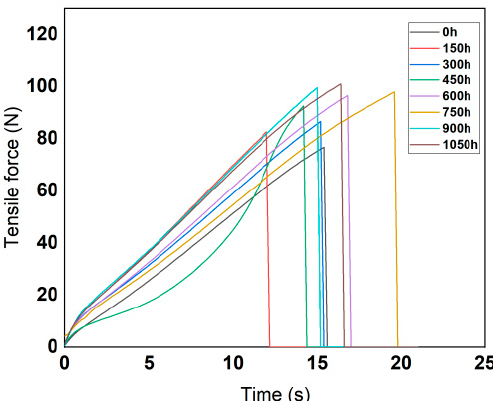
Figure 4. Variation curves of fluorinated silicone rubber tensile force with time.